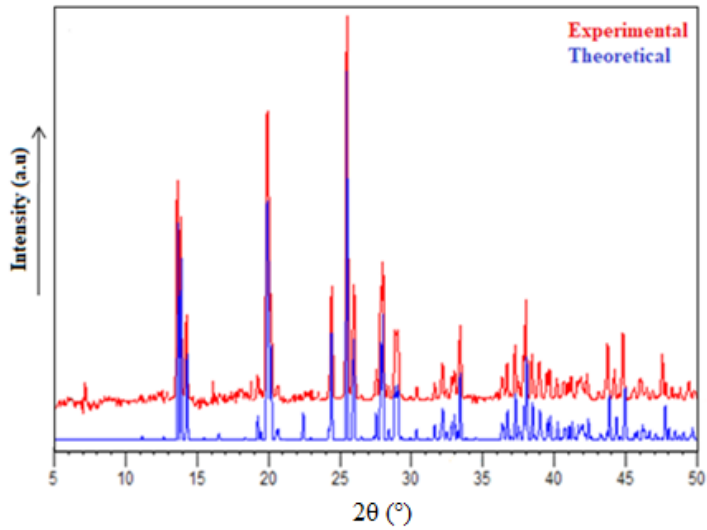
Figure 1. Experimental and theoretical powder diffractograms.